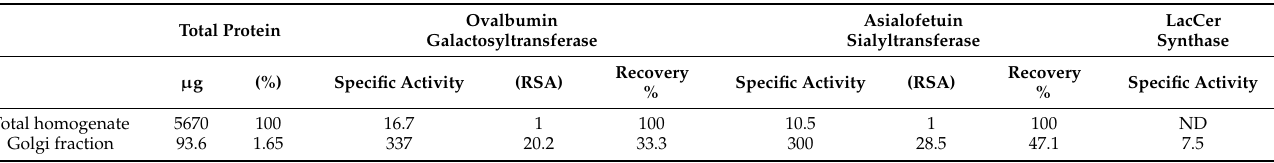
Figure 4. Detection of LacCer synthase activity by classical radioisotope method. Various amounts of homogenate protein prepared from 3 different sources were incubated in reaction mixtures containing tritiated UDP-Gal together with (+) or without (-) the acceptor substrate GlcCer. Quantitation was performed by using descending paper chromatography of the mixture followed by liquid scintillation counting (Panel ( A )). True LacCer synthase activity is assumed to be the one detected in the presence (+) of GlcCer, while the values obtained in its absence (-) represent the background. For comparison, the results obtained with the same enzyme sources by the novel method were presented at a single protein concentration (Panel ( B )). Table 1. LacCer synthase activity determined by the classical radioisotope method in a Golgi fraction prepared from human dermal